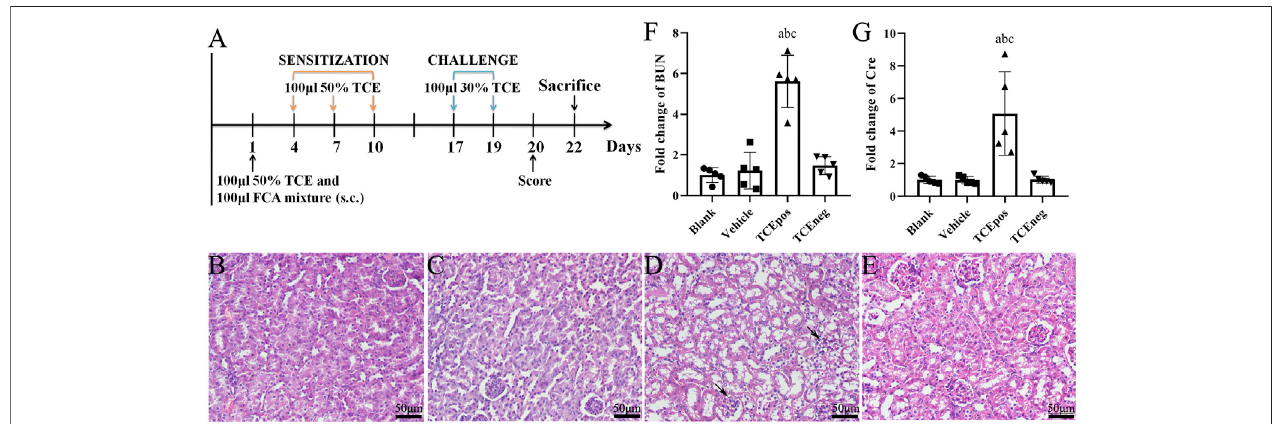
FIGURE 1 | TCE sensitization caused the glomerular damage with fi ltering dysfunction. (A) Flow diagram of BALB/c mouse model of TCE skin sensitization. (B-E) Representative pictures of H&E staining ( n (cid:1) 5 per group in blank control group (B) , vehicle control group (C) , TCEpos group (D) , and TCEneg group (E) . Black arrows show glomerular cell edema (magni fi cation, × 400). (F, G) Relative expression of BUN and Cre in TCE-treated mice ( n (cid:1) 5). Data are presented as mean ± SD and determined by one-way ANOVA. a P < 0.05, vs. blank control group; b P < 0.05, vs. vehicle control group; c P < 0.05, vs. TCEneg group. Scale bars: 50 µm.